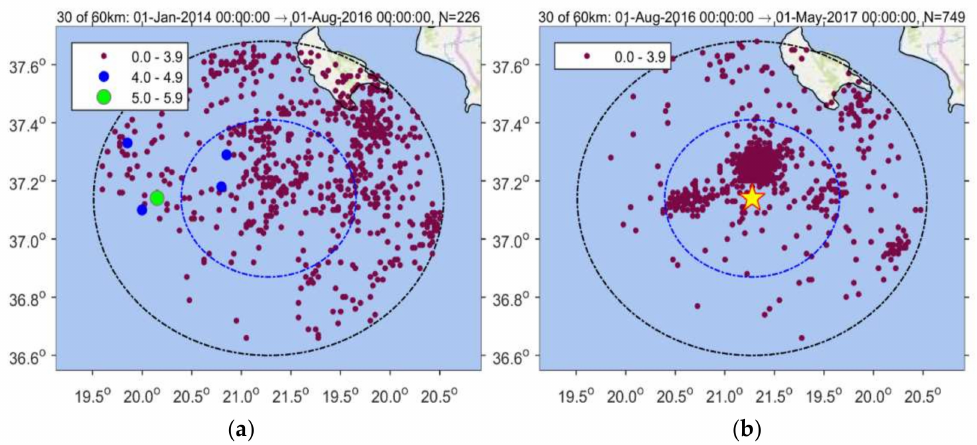
Figure 7. Seismicity within radii of 30 km and 60 km around the 25 October 2018 mainshock epicenter from 1 January 2014 up to 1 August 2016 (background seismicity state BGS 1) ( a ), and from 1 August 2016 up to 1 May 2017 (cluster 1) ( b ). Color panel illustrates earthquake scaling of magnitude size; star shows mainshock